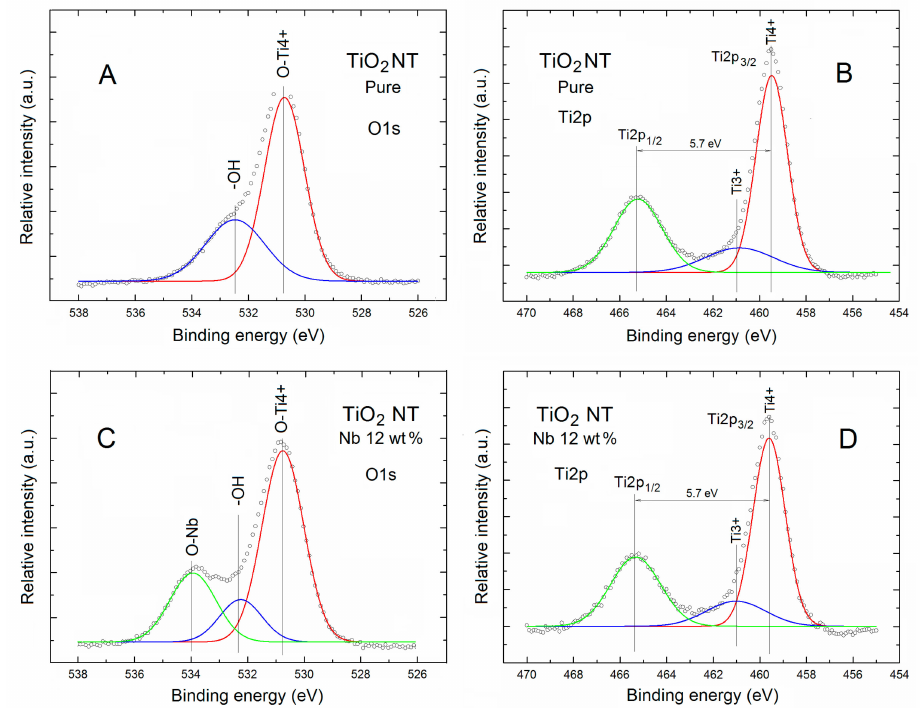
Figure 2. XPS O1s and double Ti2p spectral lines of pure ( A , B ) and Nb-doped ( C , D ) TNT, respectively, after Gauss deconvolution. The circles correspond to the experimental curves after linear smoothing, whereas the color lines correspond to the respective deconvoluted